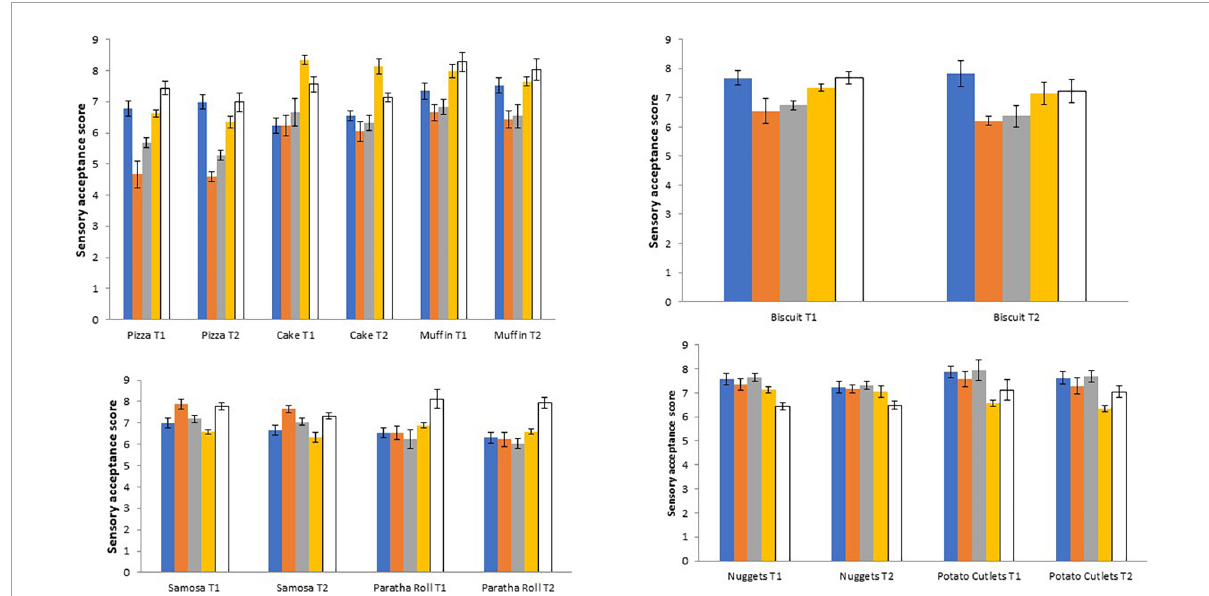
FIGURE2 Sensory evaluation of various bakery (Pizza, cake, and muffins were evaluated for color, taste, odor, texture, and overall acceptability; Biscuits were evaluated for color, taste, crispness, texture, and overall acceptability), snack (Chicken nuggets and potato cutlets were evaluated for color, flavor, tenderness, juiciness, and overall acceptability), and fried (parathas and samosa of color, aroma, texture, taste, and overall acceptability)